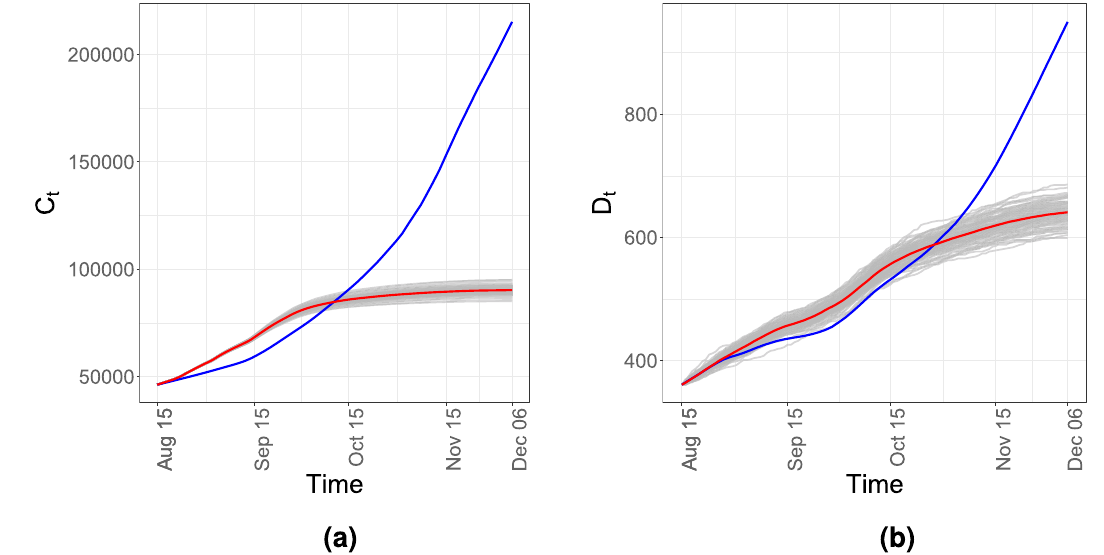
Figure 4. The 100 simulated trajectories when testing rate is increased by 30% are in gray while the mean of them are presented in red. The observed C t and D t in Utah are marked in blue.